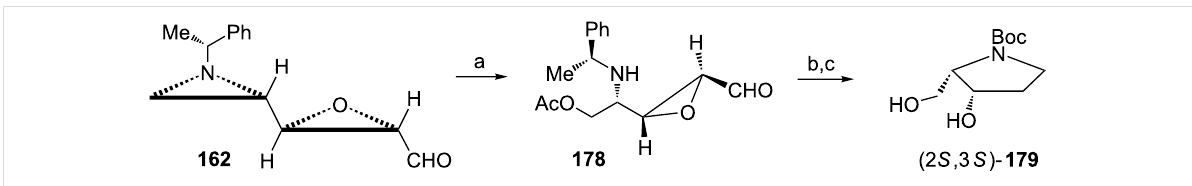
Scheme 45: Syntheses of (2 S ,3 S )- N -Boc-3-hydroxy-2-hydroxymethylpyrrolidine ((2 S ,3 S )- 179 ). Reagents and conditions: a) AcOH, CH 2 Cl 2 , rt, 6 h; b)